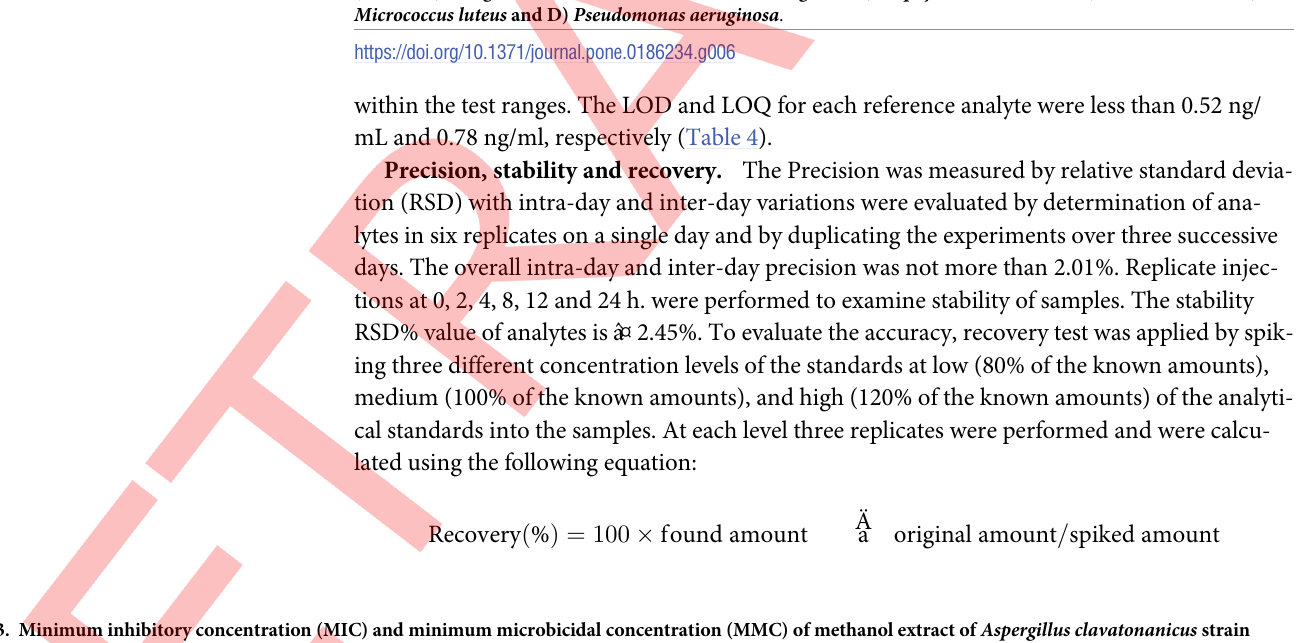
Table 3. Minimum inhibitory concentration (MIC) and minimum microbicidal concentration (MMC) of methanol extract of Aspergillus clavatonanicus strain MJ31 against bacterial and yeast human pathogens. Concentration